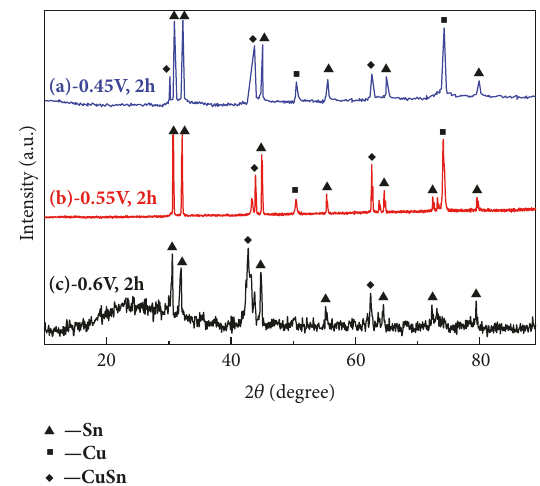
Figure 7: XRD patterns of tin deposits obtained from the [Bmim]HSO 4 /H 2 O mixture (30% H 2 O, v/v) solution containing 40mM SnO at different deposition potential for 2h. (a) -0.45 V, (b) -0.55V, and (c) -0.6V. Temperature: